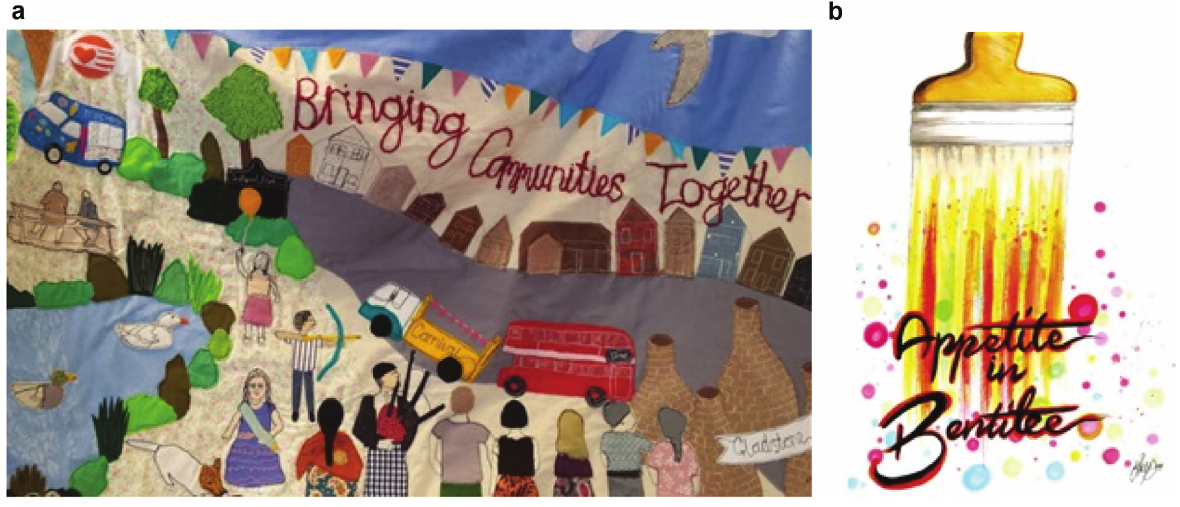
Figure 3. Creative case studies (Source: intervention by Nicola Winstanley and Sarah Nadin, photographs by Jenny Harper). (a) Textile banner; (b)